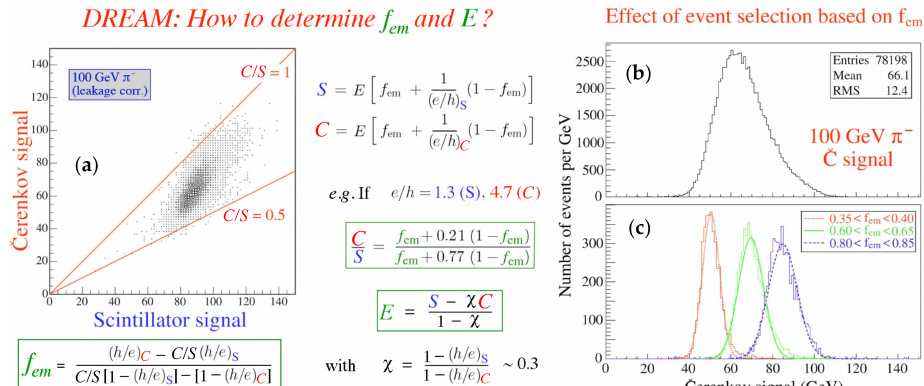
Figure 8. The dual-readout method used to determine the em shower fraction and the hadron energy, based on the S and C signals ( a ). The non-Gaussian 100 GeV signal distribution ( b ) is a superposition of Gaussian distributions with different f em values ( c ).